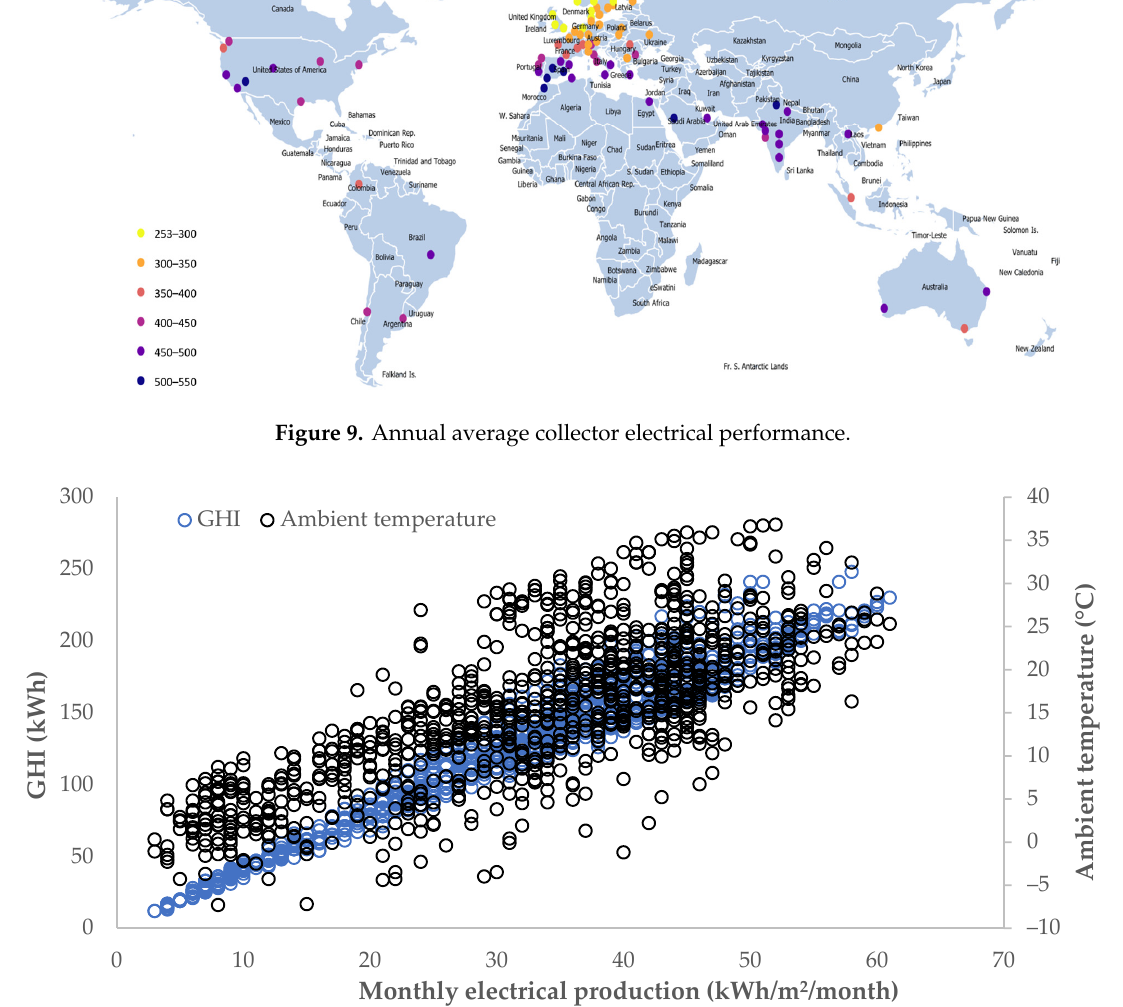
Figure 10. Correlation of collector electrical production with global horizontal irradiation (GHI) and ambient temperature.